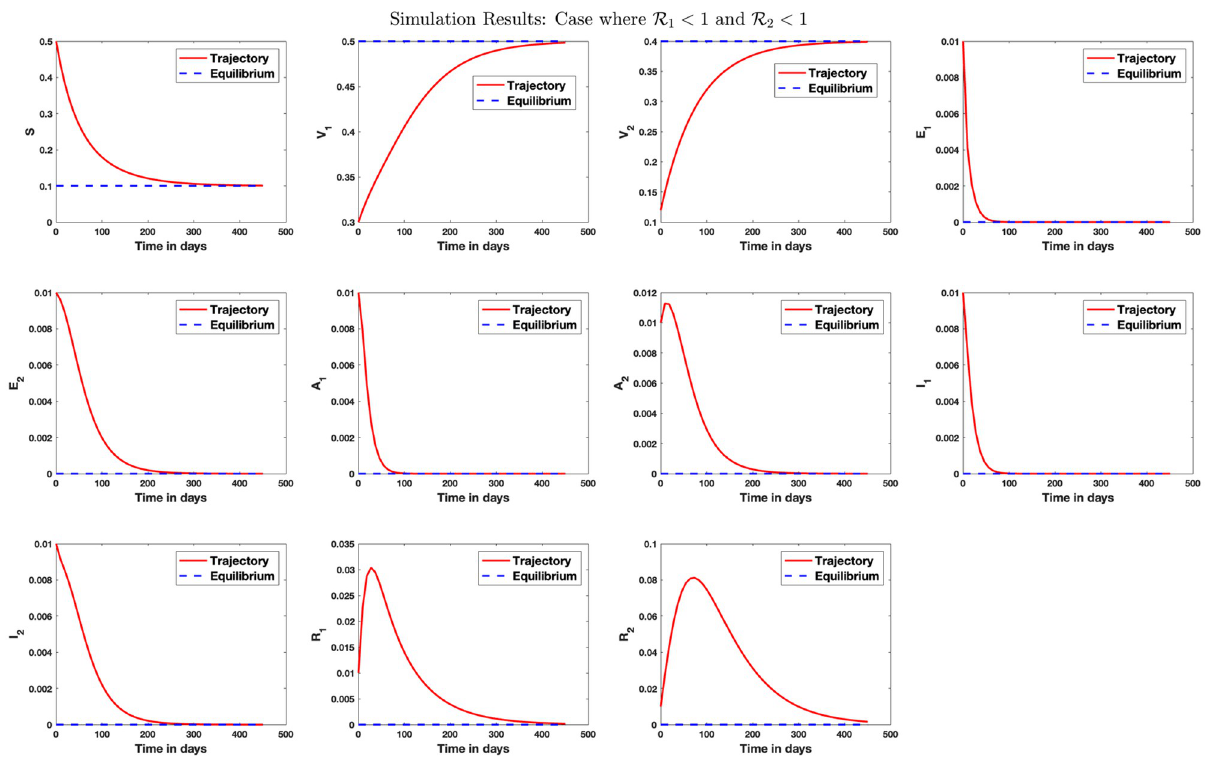
Fig 3. Stability analysis for the disease-free equilibrium. Case where R 80.3, q 1 = 0.5, q 2 = 0.4, λ 1 = 1/5, λ 2 = 1/4, r 1 = 1/10.5, r 2 = 1/9, θ 1 = 0.09, θ 2 = 0.1. The reproduction numbers R ¼ 0 : 74 . On the long run, the susceptible population reduces to 10% of the population size while the population receiving vaccination against strains R 0 1 and 2 increases to 50% and 40% of the population size, respectively, in this scenario. The exposed and infected population size converges to zero on the long run. The disease-free equilibrium is calculated as E